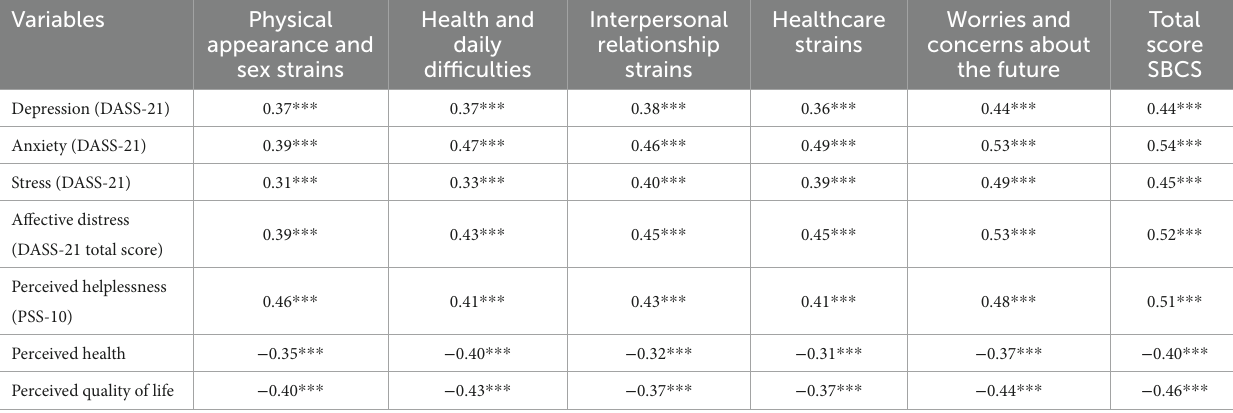
TABLE 7 Correlations between SBCS factor and total scores and scores on depression, anxiety, stress, perceived helplessness, and perceived health and quality of life ( N = 420). Variables Physical